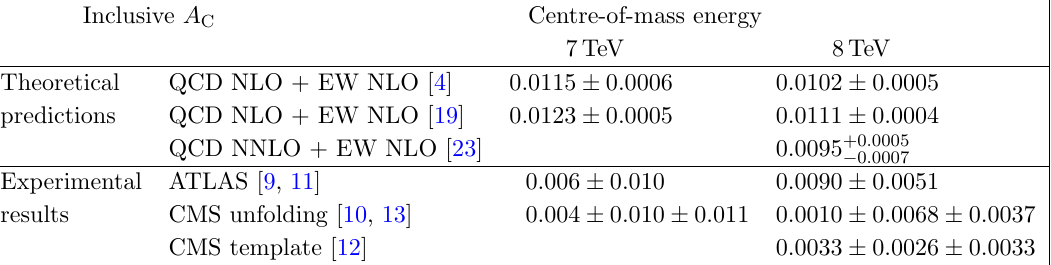
Table 1 . Overview of the most recent theoretical predictions for the inclusive A C at the LHC at p s = 7 and 8 TeV, along with the experimental results from the ATLAS and CMS Collaborations. The uncertainties in all theoretical predictions are dominated by the uncertainties due to scale vari- ations. The uncertainties in the experimental CMS results are given separately as statistical ((cid:12)rst total uncertainty is quoted. The ATLAS and CMS experimental results are described in section